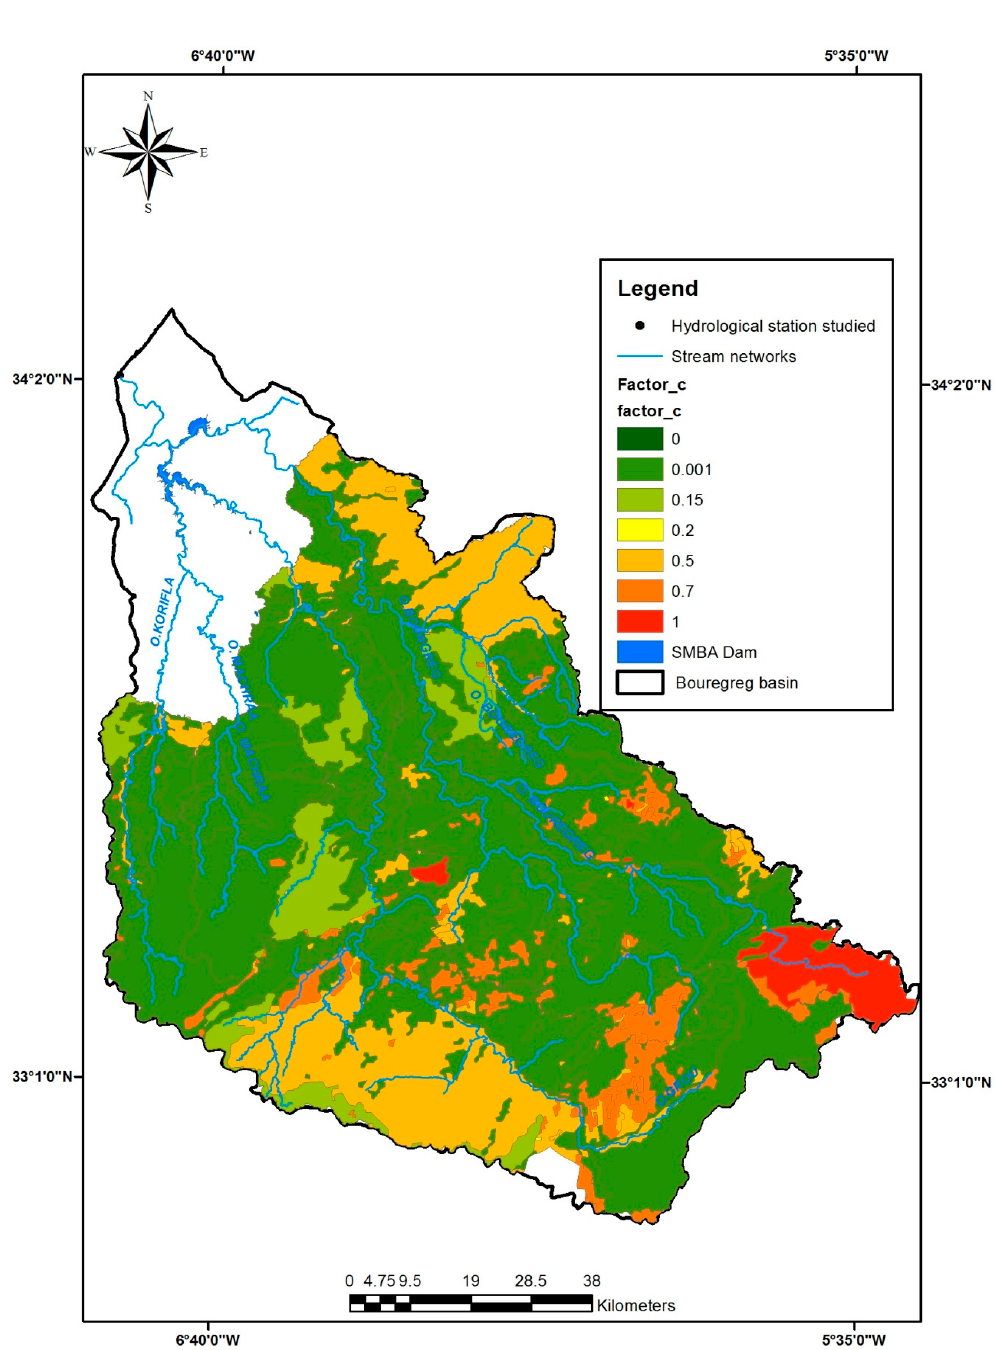
Figure 8. Factor C of the Bouregreg basin at the four hydrological stations.